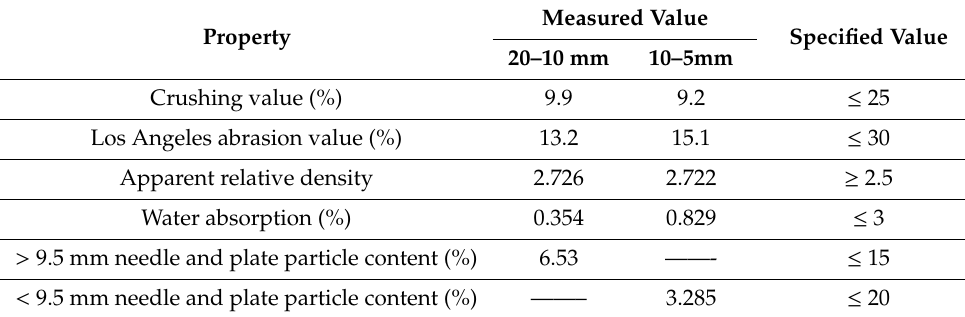
Table 1. Properties of coarse